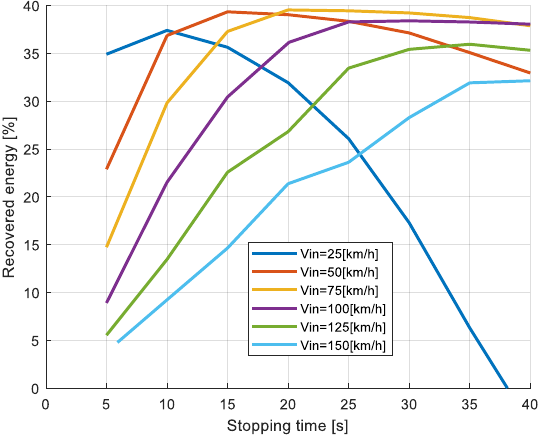
Figure 14. Recovered energy fraction versus stopping time at various starting speeds.